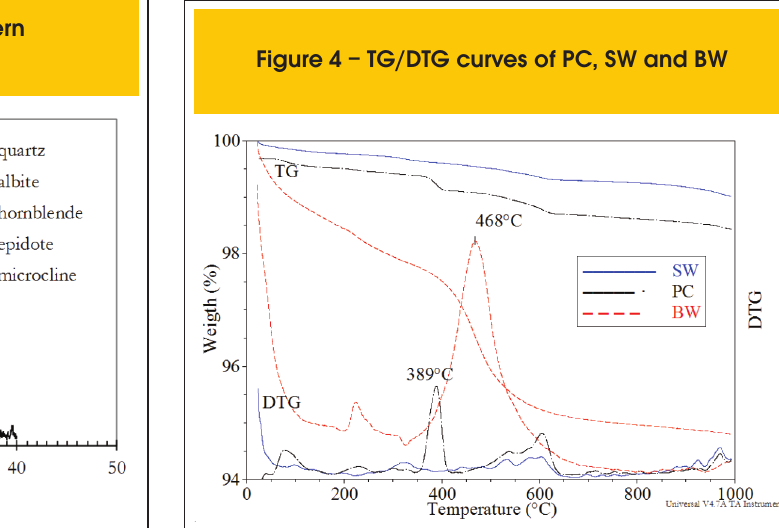
Figure 2 – X-ray diffraction pattern of stone cutting waste (SW)